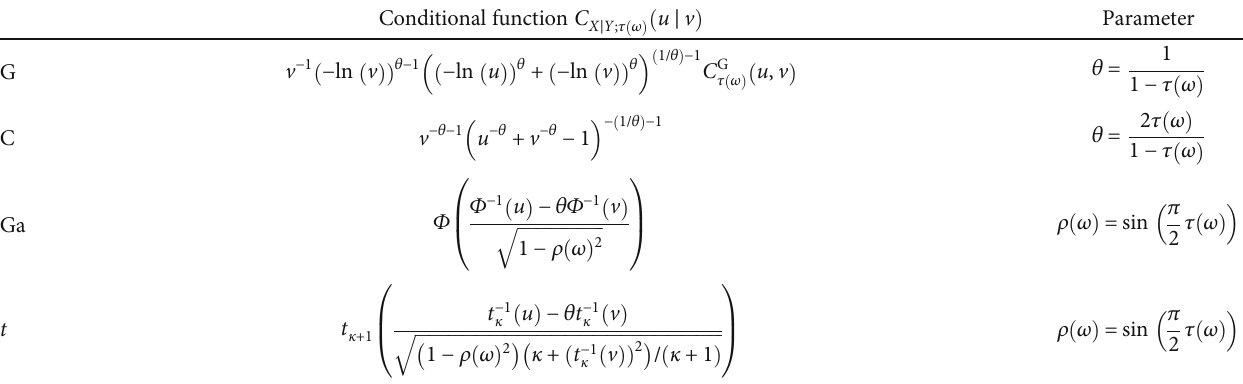
t copulas and the expression of its parameter as the function of τ ð ω Þ Table 3: Conditional function C X j Y ; τ ð ω Þ for Archimedean, Gaussian, and